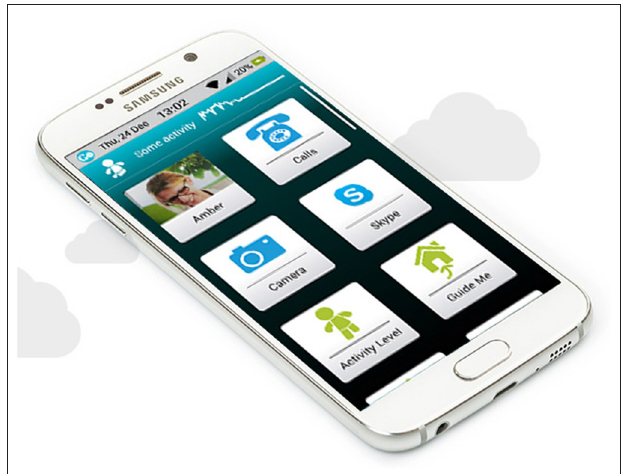
FIGURE 1 | The Samsung smartphone with custom GoLivePhone User Interface, specifically designed for and evaluated with older adults (picture by Gociety Solutions in